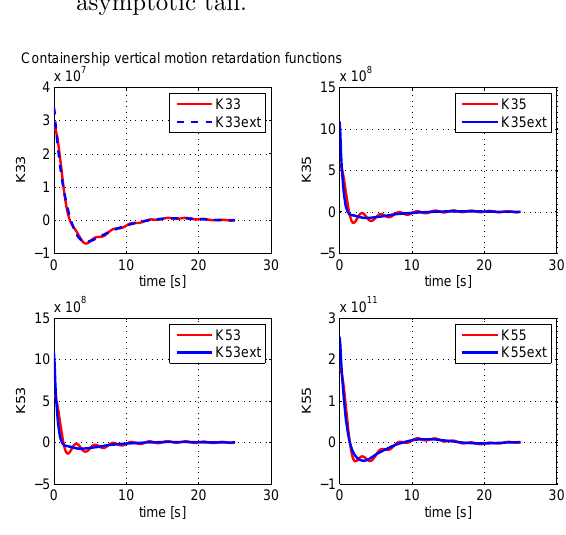
Figure 3: Potential damping computed by hydrody- namic code and extrapolation based on asymptotic tail.